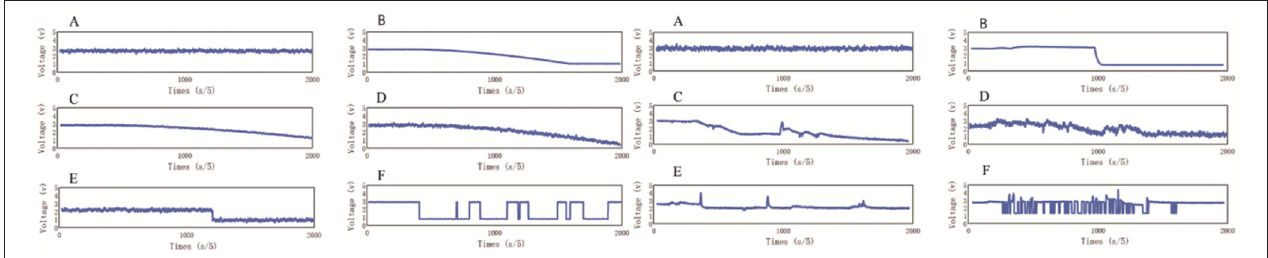
FIGURE 7 | Six signal modes of MQ-8 gas sensor under a normal environment and complex environment. (A) Normal signal; (B) The signal including heating wire disconnection (HWD) fault; (C) The signal including aging of the heating wire (AHW) fault; (D) The signal including aging of the sensitive body (ASB) fault; (E) The signal including exfoliation of the sensitive body (ESB) fault; (F) The signal including false welding of the sensitive body (FWSB) fault.